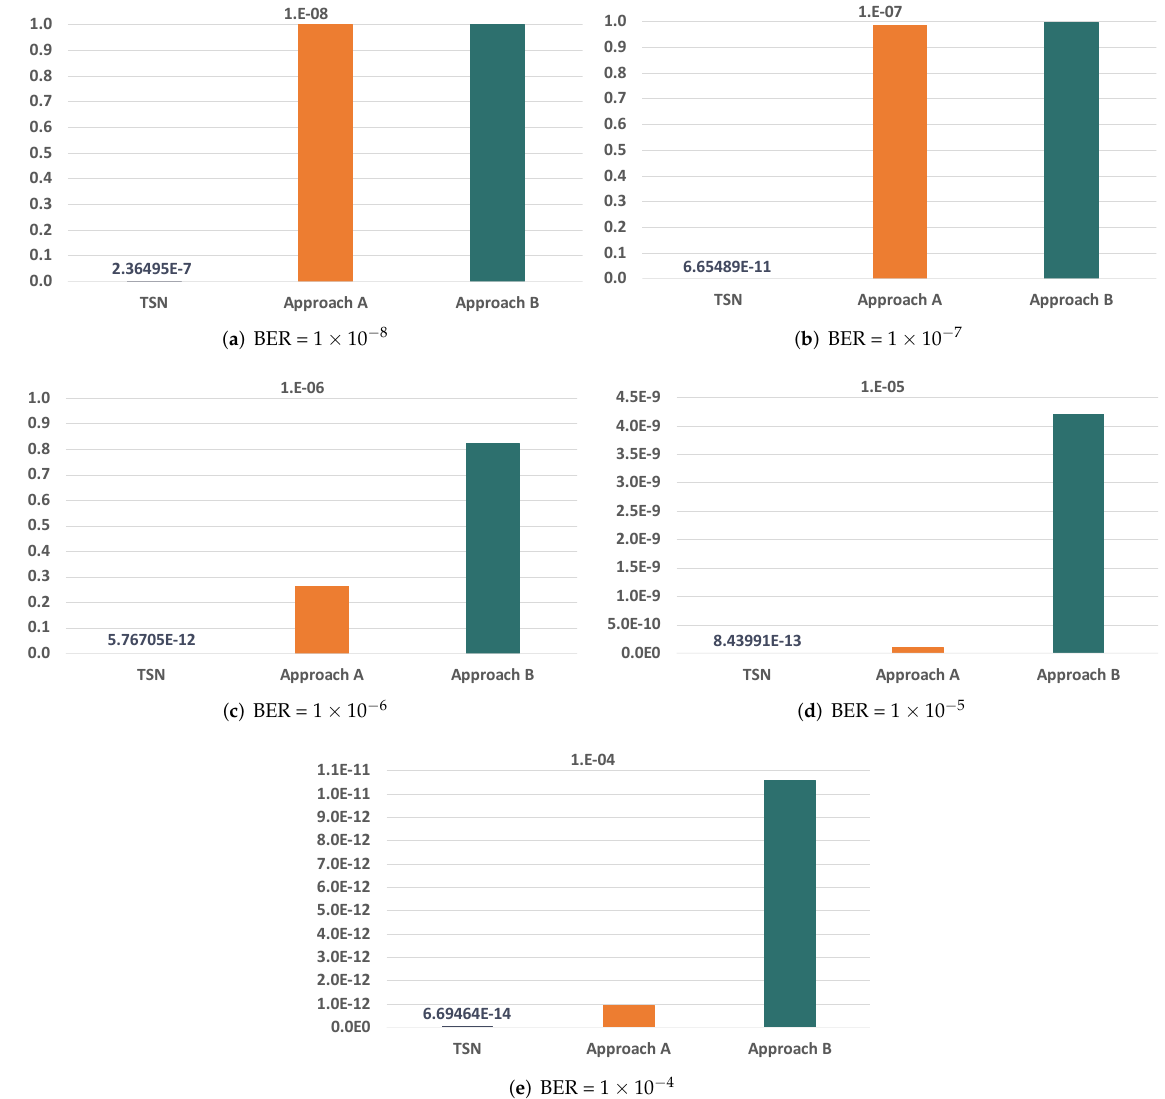
Figure 11. Zoom in the reliability achievable by TSN, approach A and approach B for BERs from 1 × 10 − 8 to 1 × 10 − 4 . TSN is represented in grey, approach A in orange and approach B in green. The x axis represents the BER values, while the y axis represents the